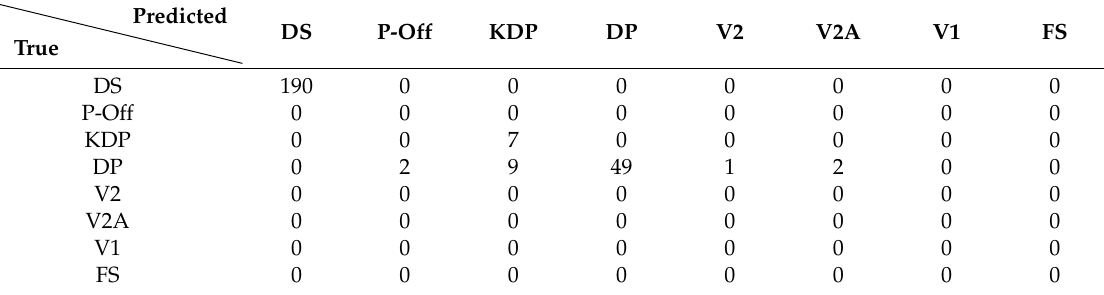
Table A1. Confusion matrix for the natural course, classical style validation set of skier 2 when using the sports biomechanics configuration of sensors.